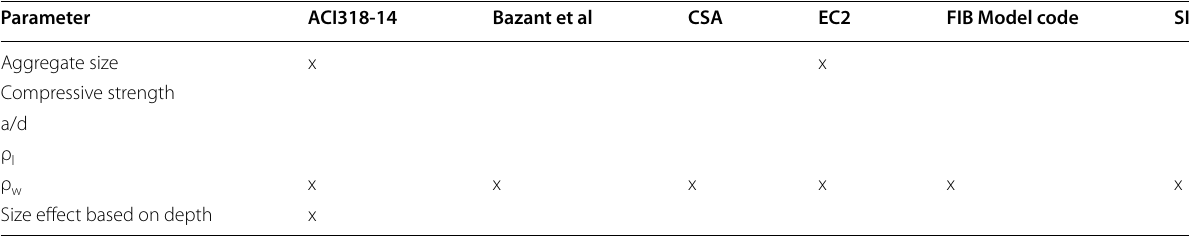
Table 1 Summary of shear parameters considered in different